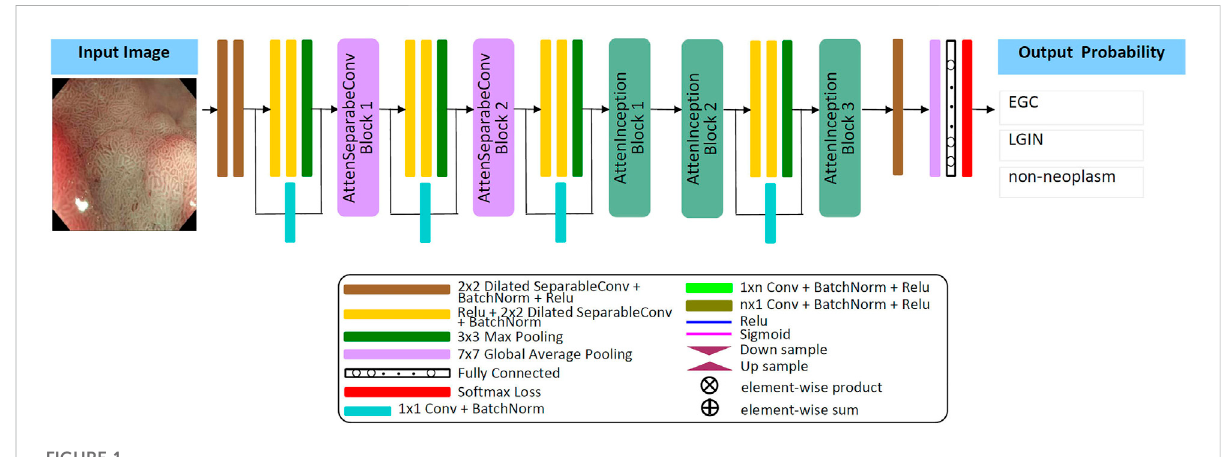
FIGURE 1 The framework of the classi fi cation method of gastric